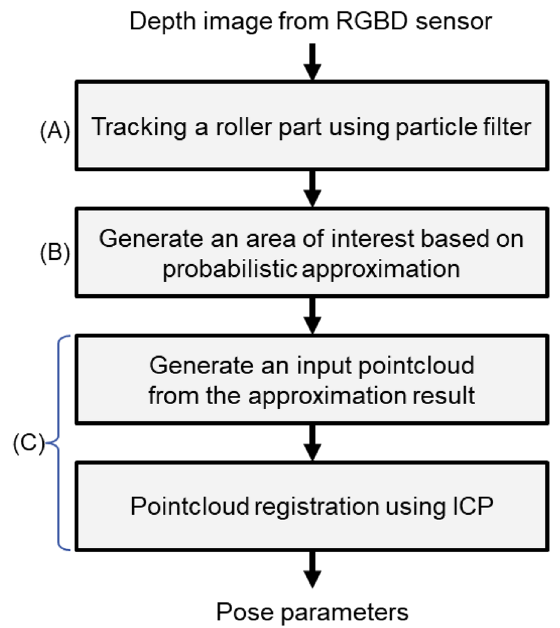
Fig. 3 Flow of pose estimation of roller